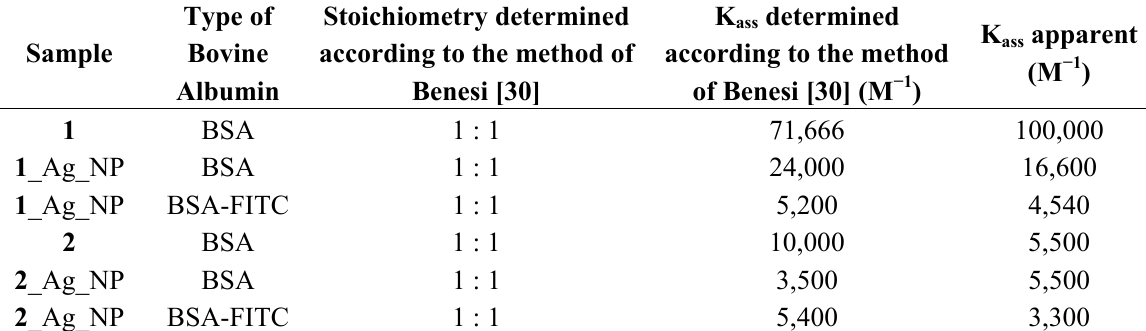
Table 2. Stoichiometry S and Association Constants K K has been calculated according 2 different methods, that of Benesi, [30] and a simplistic ass method where K is calculated as the half height of the binding curve and K dis simply as the